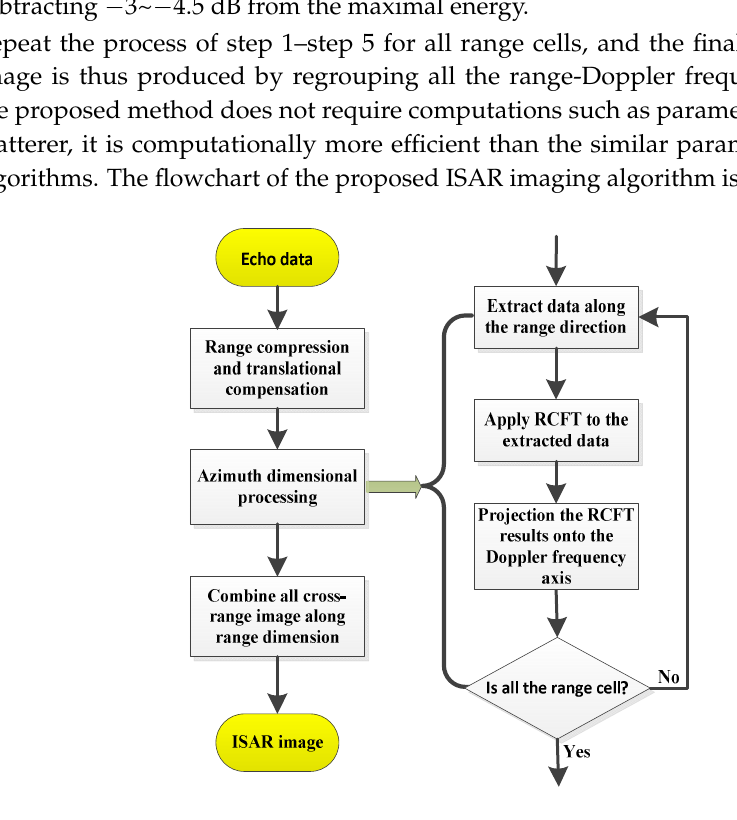
Figure 6. Flowchart of ISAR imaging based on the proposed RCFT.